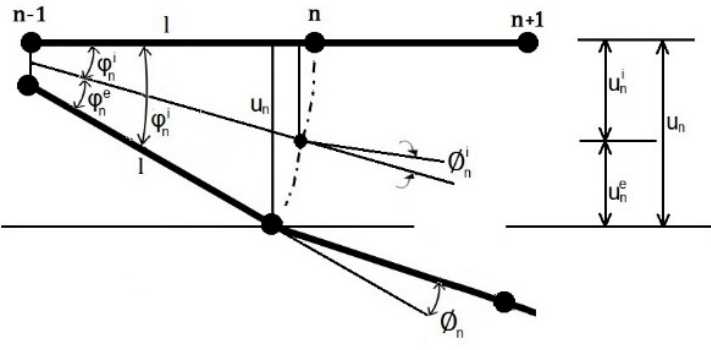
Figure 4. Model structure with initial imperfections.